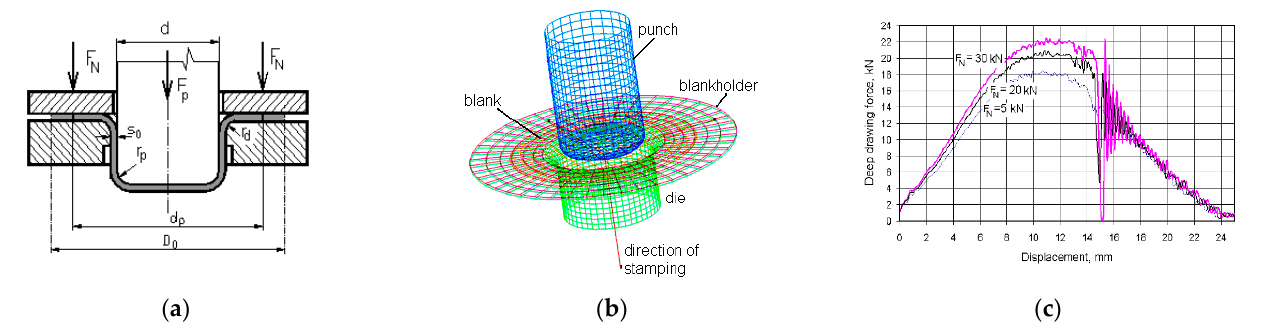
Figure 5. Cup test: ( a ) Scheme, ( b ) simulation model, ( c ) course of force for DC 05, f = 0.1.